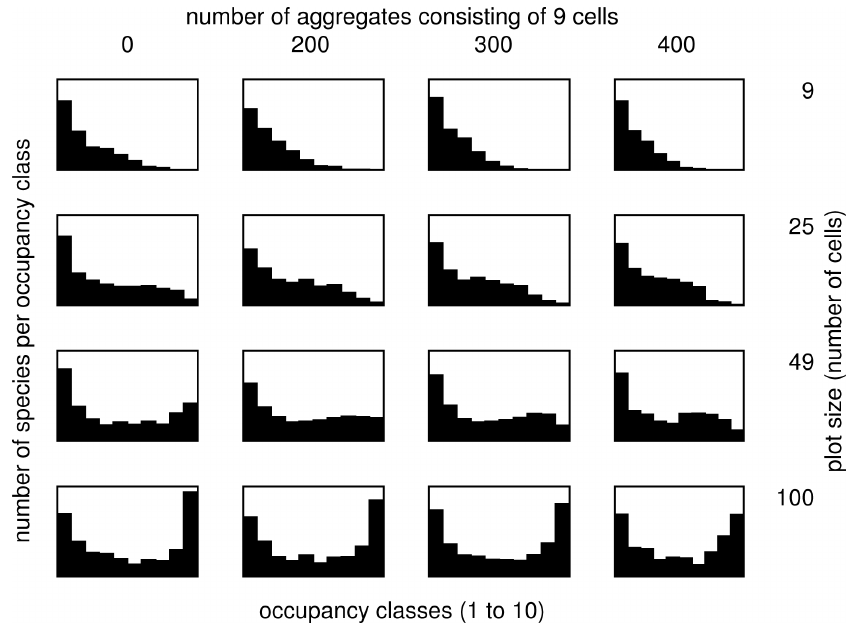
Figure 6. Average occupancy distributions of the artificial assemblage A (Fig. 5) as a function of the level of intraspecific individual aggregation and of plot size. Mean numbers of species per occupancy class of 20 repeats are indicated (for details see